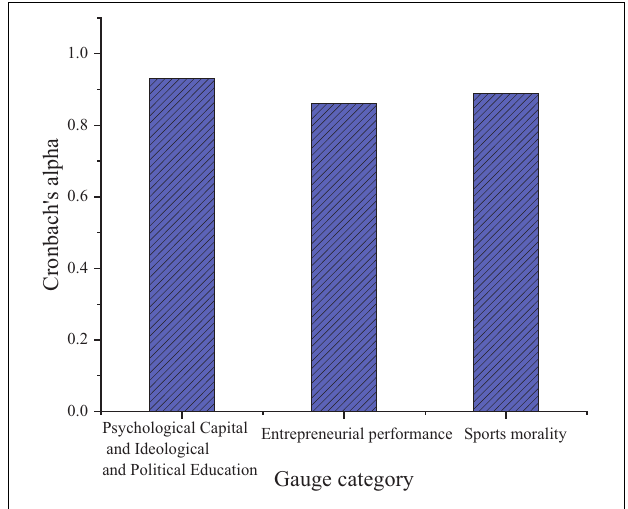
FIGURE 2 | Questionnaire survey (QS) reliability